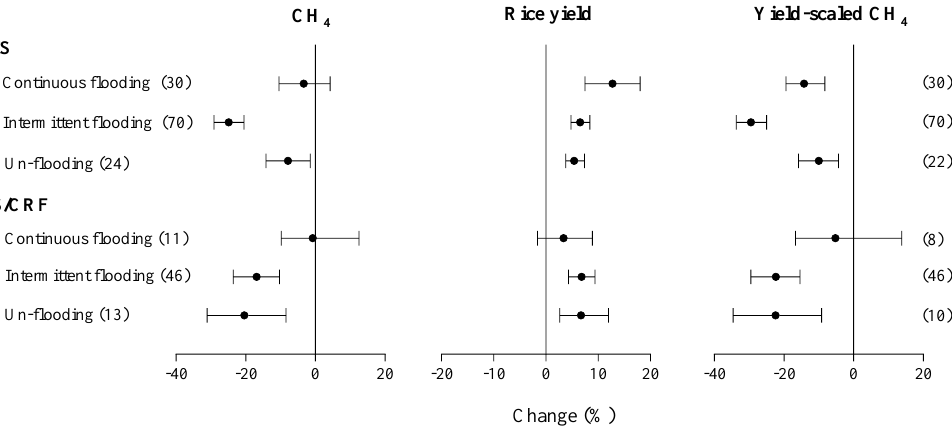
Figure 6. Impacts of water managements on the efficacy of IS and S/CRF on CH 4 , rice yield, and yield-scaled CH 4 emission from rice fields.